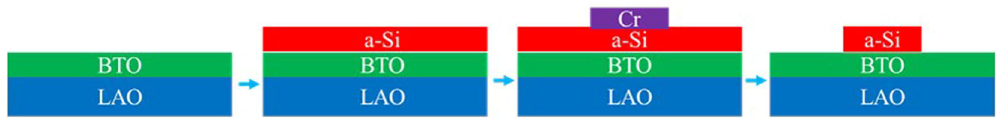
(RIE). SF 6 was used for selective Si etching, so that it did not react with the BTO film, and therefore prevented the BTO surface from becoming rough due to ion damage. It is vital to have sharp Si waveguide facets as well as a smooth BTO-Si interface to reduce the scattering loss caused by surface roughness. Previous studies that utilize HF solution for BTO etching have shown undesired rough waveguide surfaces and edges. Finally, the Cr mask and the organic residue on the device surface were removed by a ceric ammonium nitrate solution and followed by oxygen plasma ashing. Optical and Sensing Characterization. To characterize the performance of our a-Si on BTO waveguides, a broad mid-IR test station was built and shown in Fig. 6. The light source is a pulsed laser with a wavelength tunable from λ = 2.4 μ m to λ = 3.8 μ m and the linewidth is of 3 cm − 1 . The laser has a pulse repetition rate of 150 kHz, a pulse duration of 10 nano seconds, and an average power of 150 mW. Using a reflective lens, the probe light was first collimated into a fluoride fiber that has a 9 μ m core and 125 μ m cladding, and then butt coupled into the waveguide. The core of the mid-IR fiber was lined up with the smoothly cleaved front facet of the Si-on-BTO waveguide as shown in Fig. 6(b). The fine alignment between the optical fiber and the waveguide front facet was